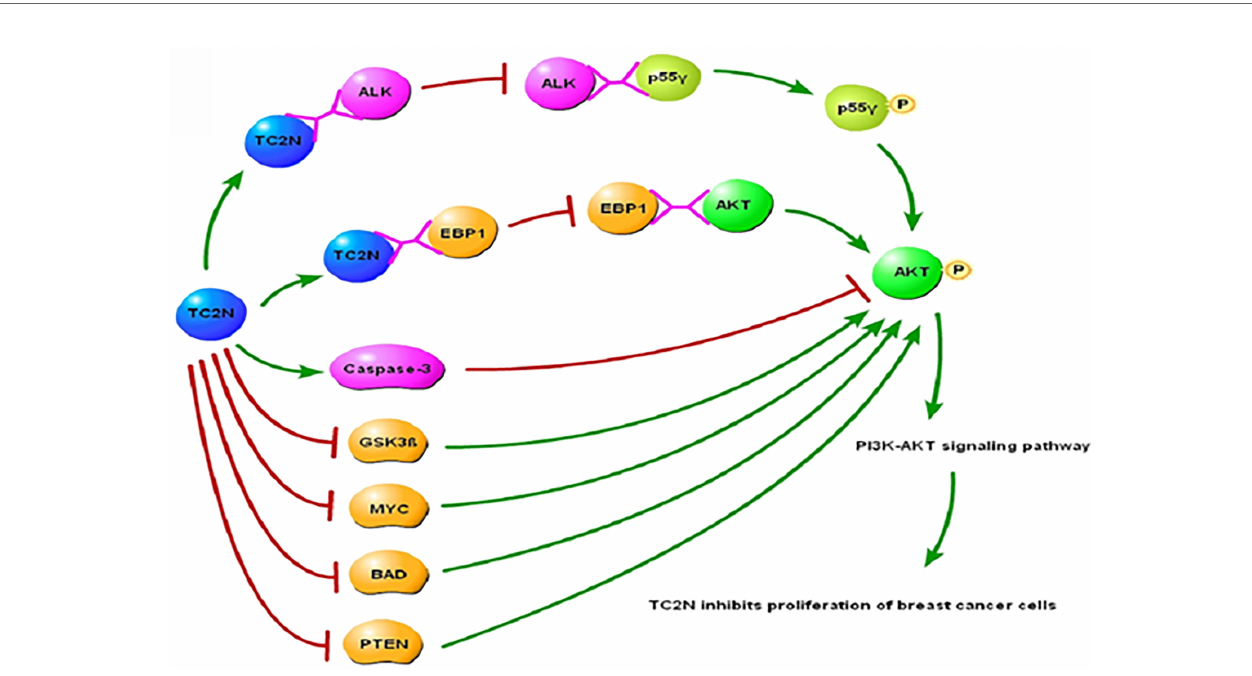
FIGURE 2 | Underlying molecular mechanisms of TC2N in PI3K-AKT signaling pathway in breast cancer. TC2N, tandem C2 domain nuclear protein; ALK, anaplastic lymphoma kinase; EBP1, ErbB-3 binding protein 1; AKT, serine threonine kinase; GSK3 b , glycogen synthase kinase-3 b ; BAD, Bcl-2-associated death promoter; PTEN, phosphatase and tensin homolog deleted on chromosome